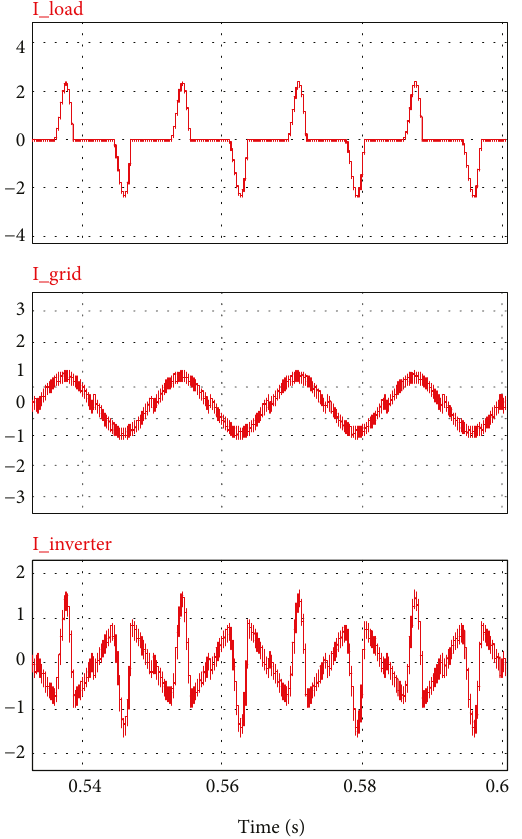
Figure 7: Operation as an active power fi lter. From (a) to (c): load current (2 A/div), grid current (1 A/div), and inverter current (1